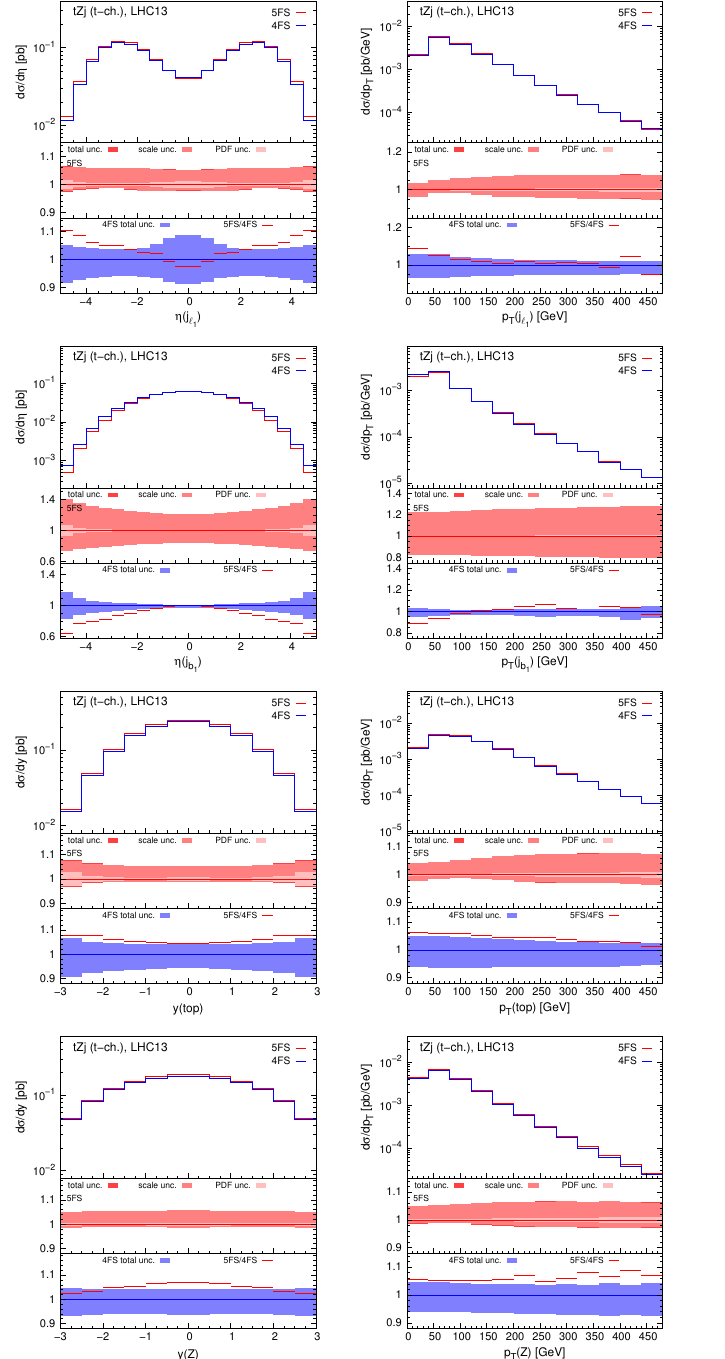
Figure 3 . Comparison between 4FS and 5FS for t -channel tZj at NLO QCD. Rapidity and transverse momentum distributions are shown for the hardest light jet, the hardest b -tagged jet, the top quark and the Z boson.